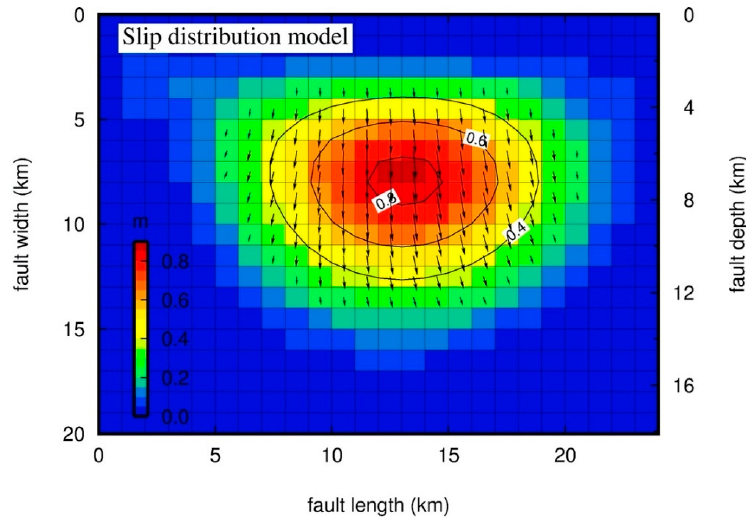
Figure 9. Coseismic slip distribution model for the 2020 Yutian event. Black arrows indicate slip direction for each patch.